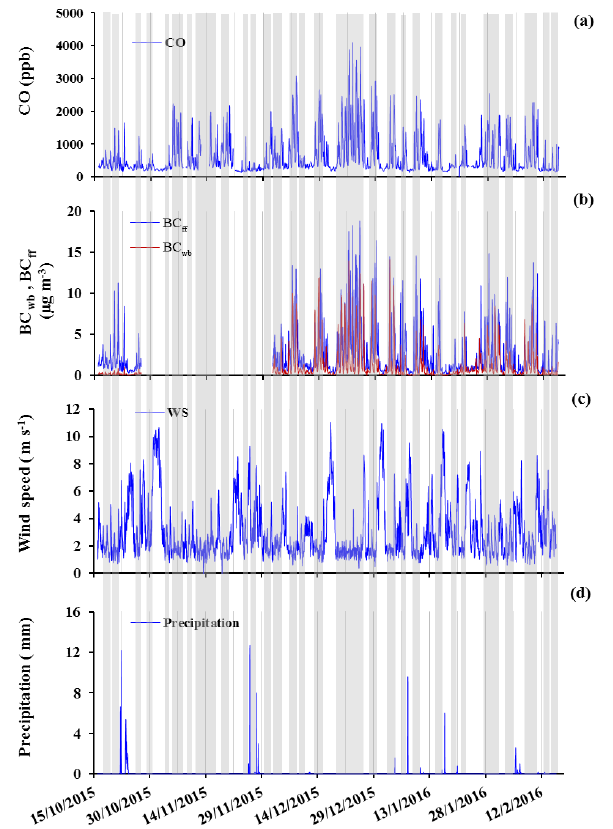
Figure 7. Temporal variability of (a) CO, (b) BC wb and BC ff frac- tions, (c) wind speed and (d) precipitation for the experimental pe- riod. Grey frames correspond to smog periods (SPs), while the re- maining frames represent non-smog periods (nSPs).